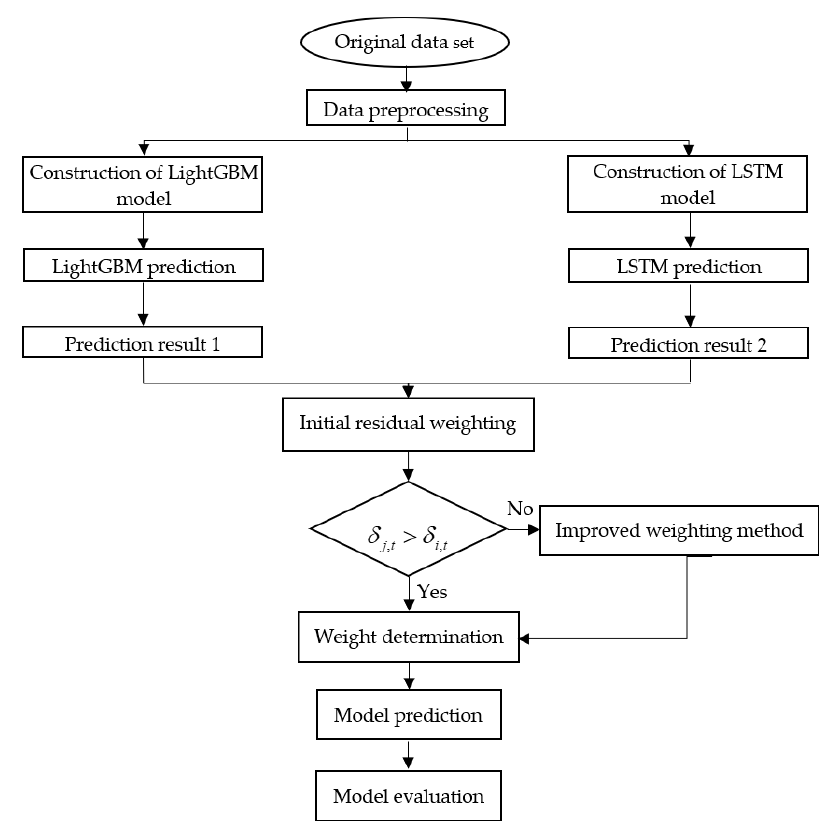
Figure 3. Prediction flow of LSTM-LightGBM variable weight combination model.